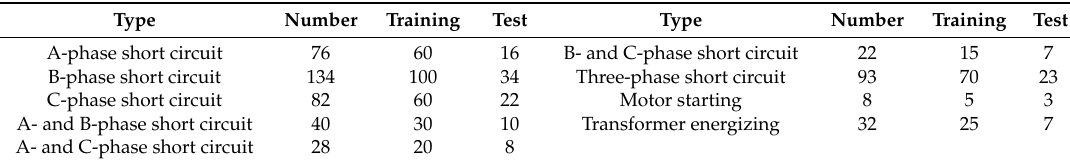
Table 1. Test and training samples and their